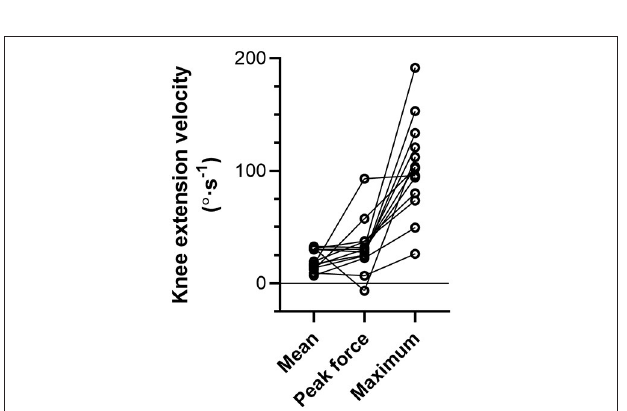
FIGURE 3 | Individual left-sided knee extension velocities across participants ( n = 13) during the Nordic hamstring exercise (NHE) trial with the highest peak force. Mean refers to the mean velocity over the period when knee extension velocity was positive, peak force refers to the instantaneous velocity at peak NHE force, and maximum refers to the peak knee extension velocity during the NHE. Solid lines link the same participant, and descriptive statistics are reported in the Results section.